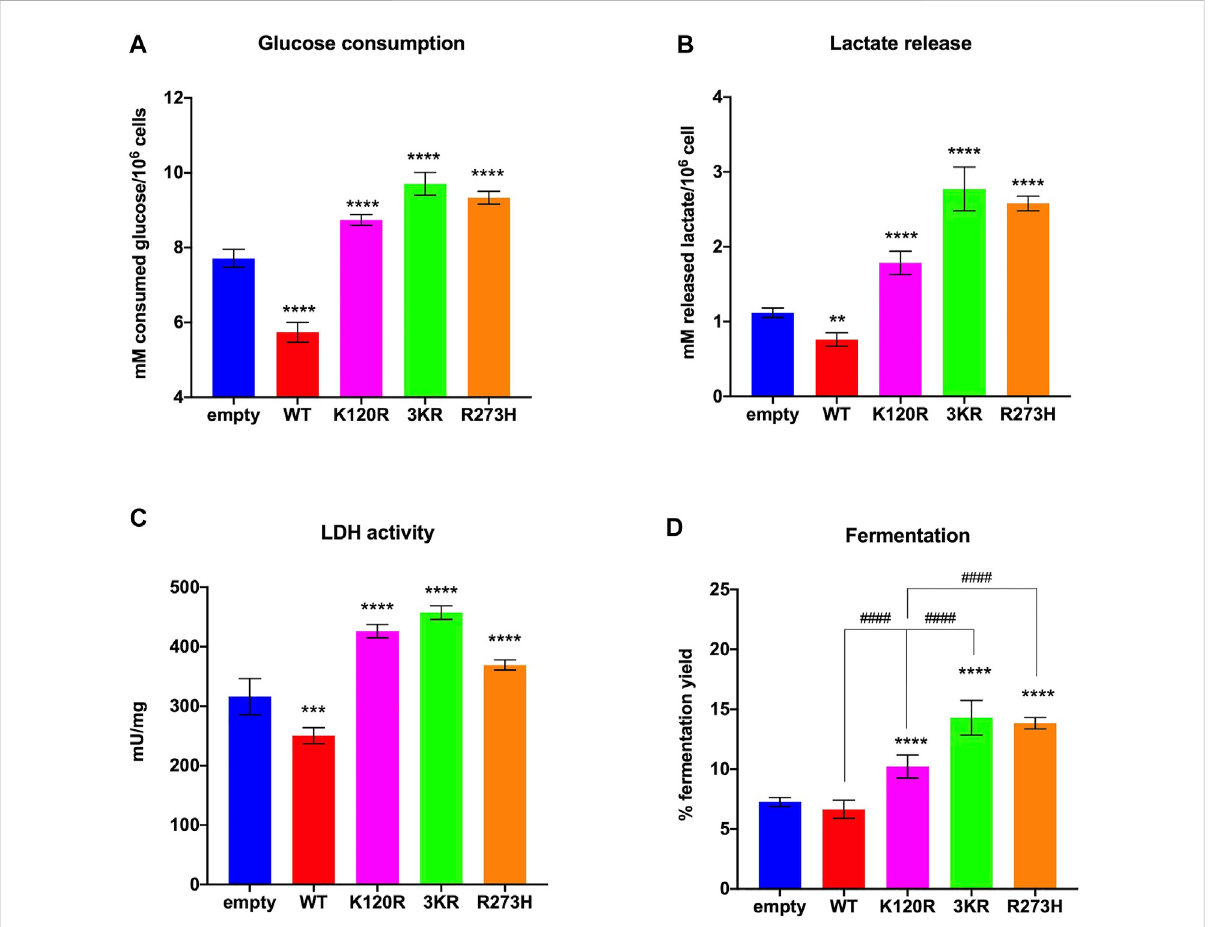
FIGURE 4 Anaerobic metabolism in HCT116 TP53 − / − cells expressing p53 WT , p53 3KR , p53 K120R , and p53 R273H proteins. (A) Glucose consumption. (B) Lactate release in the medium. (C) LDH activity. (D) Percentage of lactic acid fermentation yield. Each panel is representative of at least four independent experiments; data are reported as mean ± SD. The symbols **, ***, **** indicate signi fi cant differences for p < 0.01, 0.001, and 0.0001, respectively, between the control (empty) cells and those expressing p53 WT (WT), p53 K120R (K120R), p53 3KR (3KR) or p53 R273H (R273H); the symbol #### indicates signi fi cant differences for p < 0.0001 between p53 K120R and the indicated